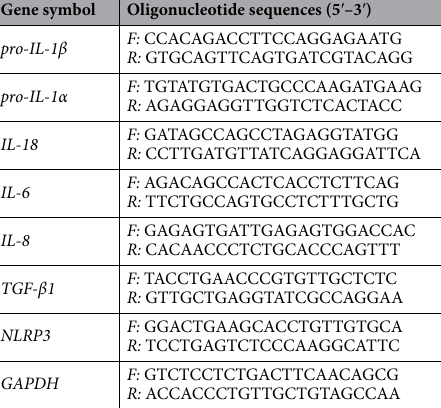
Table 1. Primers used for quantitative real-time